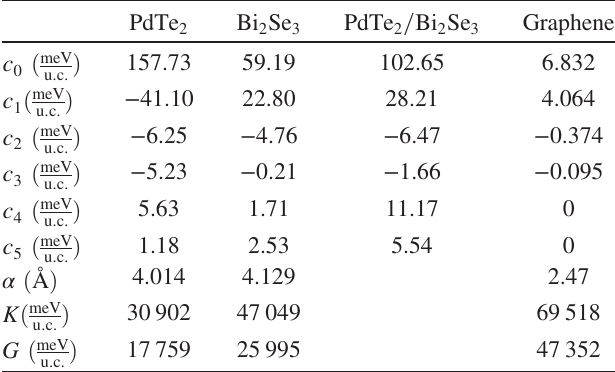
TABLE II. Material parameters for the PdTe 2 = Bi 2 Se 3 and graphene-based heterostructures used for the relaxation calcu- lations in this work. c 0 are the GSFE coefficients of Eq. (10) ; … ; 5 for the PdTe 2 = PdTe 2 , Bi 2 Se 3 = Bi 2 Se 3 , PdTe 2 = Bi 2 Se 3 , and the graphene-graphene interfaces (u.c. stands for the area of the 2D unit cell). α are the lattice constants for PdTe 2 , Bi 2 Se 3 , and graphene. K and G stand for the bulk and shear